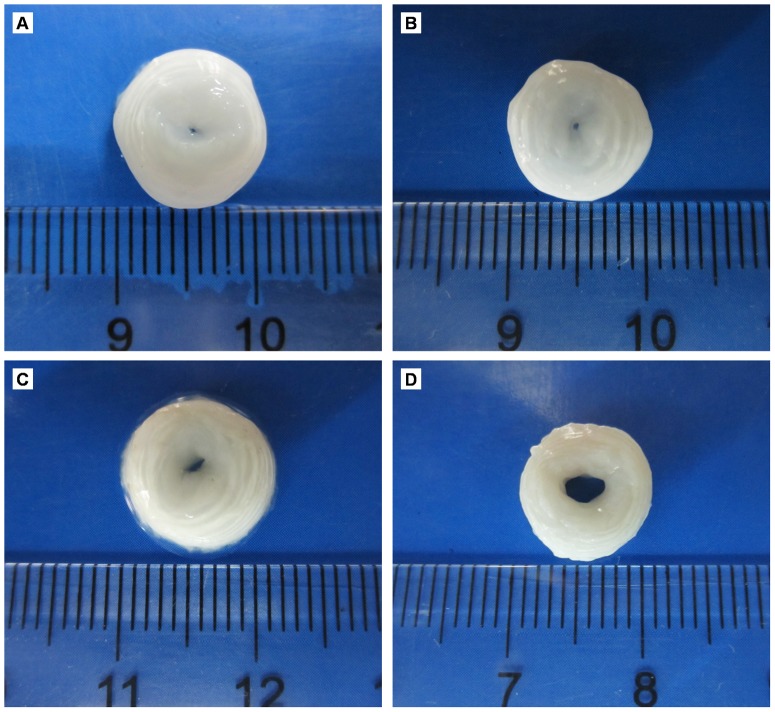
Representative macroscopic images of AF before and after decellularization.(A) Triton X-100, (B) SDS, (C) trypsin, (D) control.